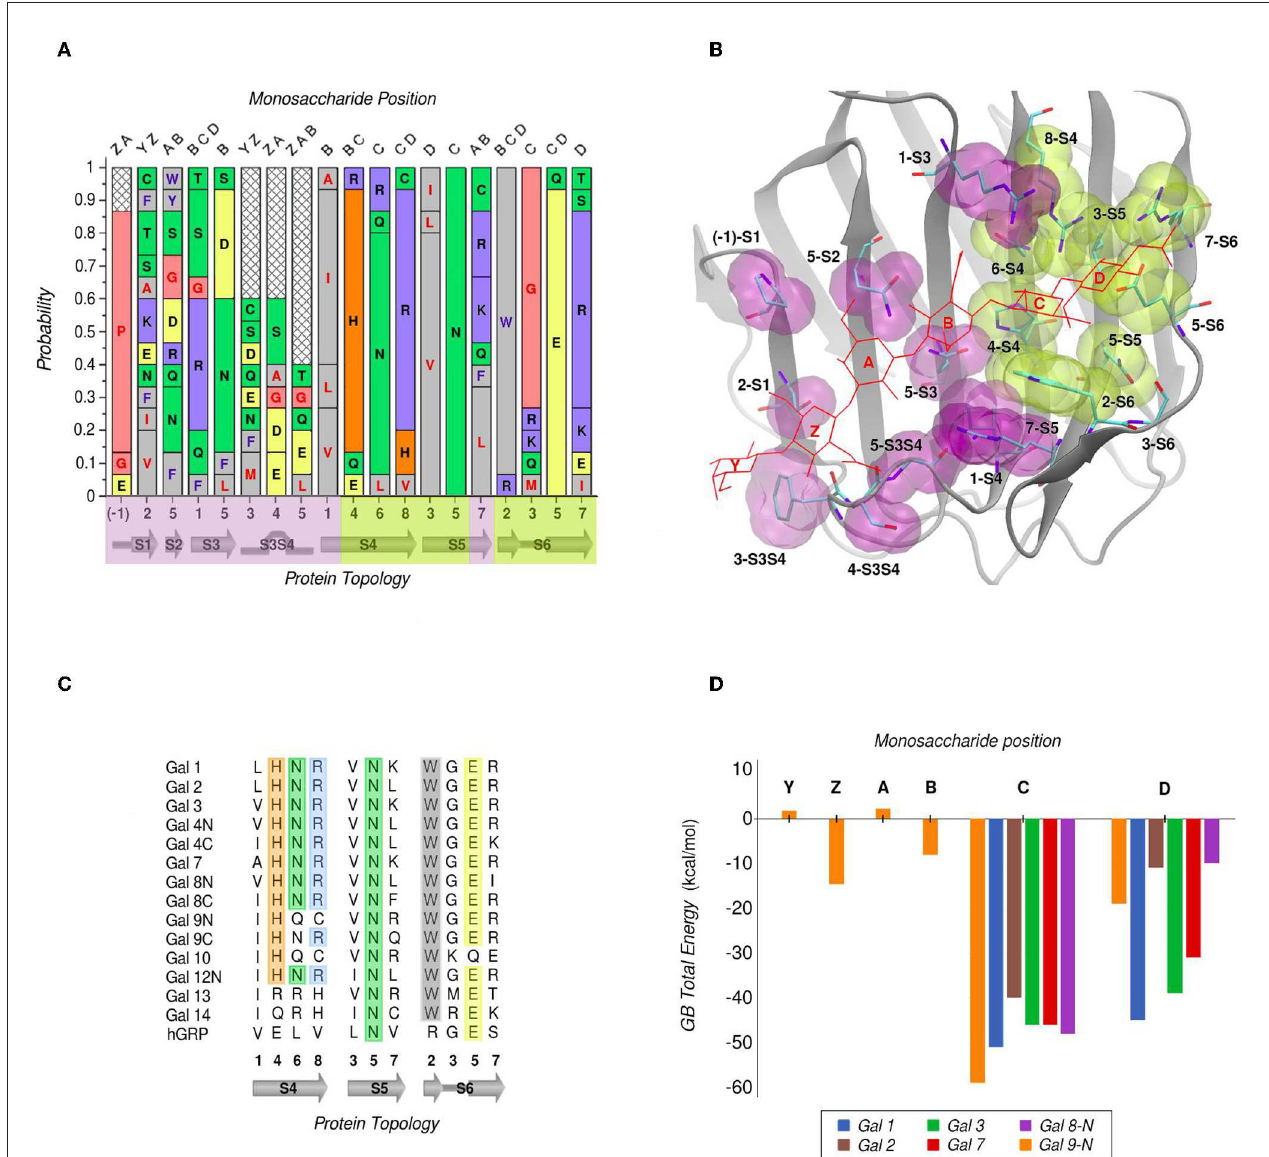
FIGURE 3 | Amino Acid composition of human galectins’ CBS based on a topological analysis (Gal-12C excluded). (A) Probability graph for each topological position. Each residue is colored by its physicochemical properties. The protein topology naming corresponds to the piece of secondary structure under study, preceded by a number which indicates the relative position of each particular residue in that piece of secondary structure (e.g., “5-S2” corresponds to the position no. “5” of the “S2” β -strand). (B) Tridimensional representation of the Gal-9N, with the main residues of the CBS surface, highlighted as yellow (most conserved) or purple (least conserved). Hexasaccharide molecule is depicted with red lines and its monosaccharide units named with letters Z-Y-A-B-C-D. (C) Residue comparison along S4-S6 β -strands. (D) Individual contribution per monosaccharide to the total Binding Energy, calculated with the General Born method (Guardia et al., 2011). “Reprinted (adapted) with permission from Guardia et al. (2011). Copyright (2011) American Chemical